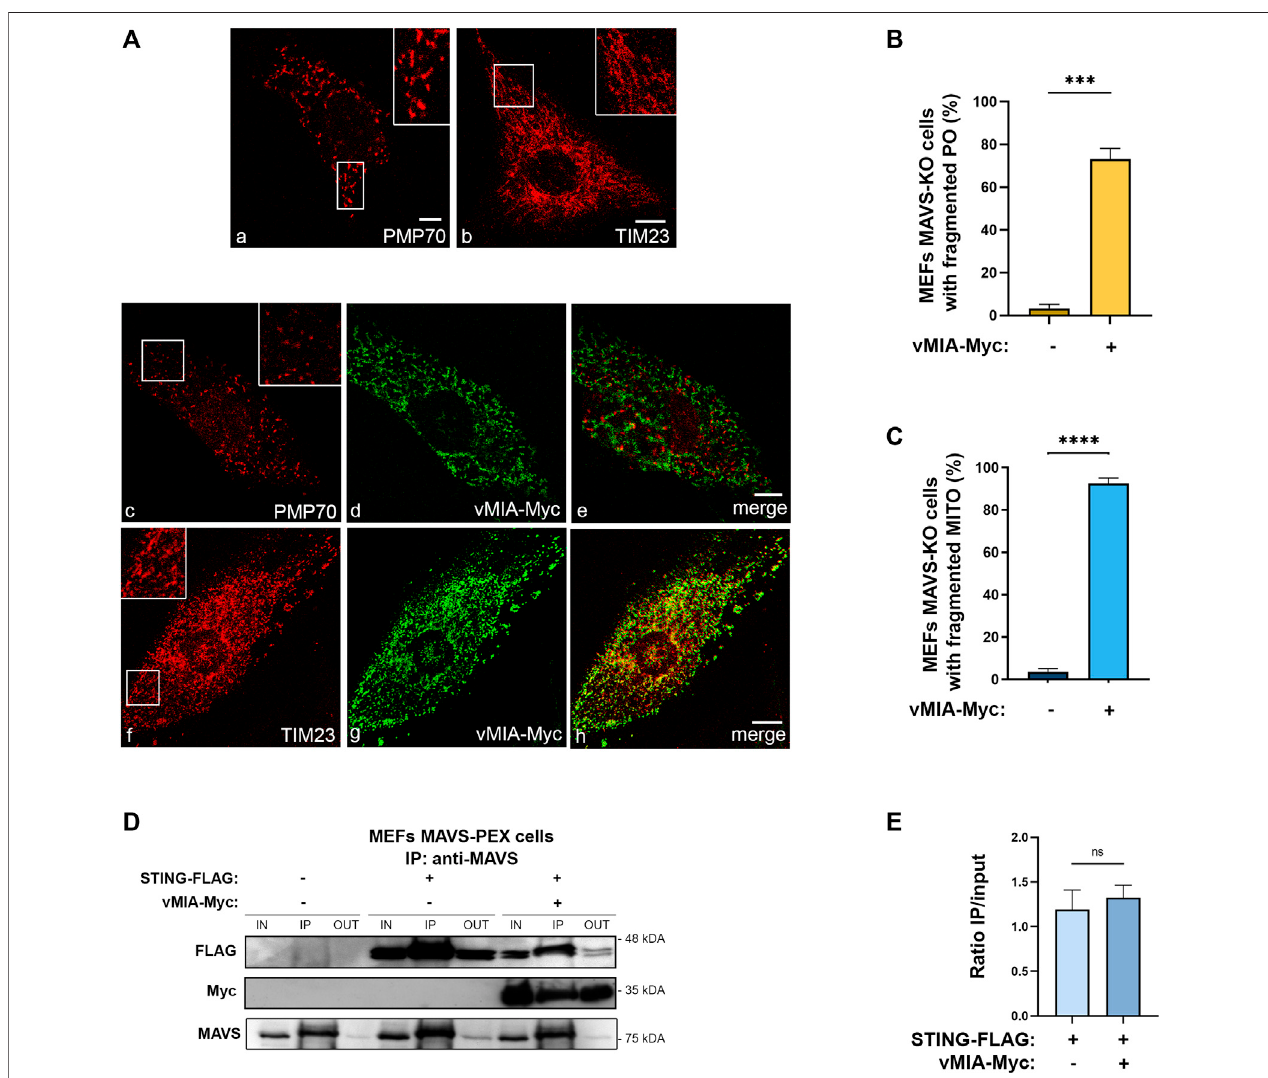
FIGURE3| vMIA-inducedperoxisomalandmitochondrialfragmentationisindependentofMAVS.vMIAdoesnotdisruptSTING-MAVSinteractionatperoxisomes. (A) Immuno fl uorescenceanalysesofMEFsMAVSKOcells:(a,b)peroxisomalandmitochondrialmorphologiesincontrolcells:(a)anti-PMP70,(b)anti-TIM23;(c – e)peroxisomal morphologyuponoverexpressionofvMIA-Myc:(c)anti-PMP70,(d)anti-Myc,(e)mergeimageofcandd;(f,h)mitochondrialmorphologyuponoverexpressionofvMIA-Myc: (f) anti-TIM23, (g) anti-Myc, (h) merge image of f and g. Bars represent 10 µm. (B,C) Statistical analysis of peroxisomal or mitochondrial morphologies upon overexpression of vMIA-Myc in MEFs MAVS KO cells, respectively. Approximately 600 cells were analysed per condition. (D) Co-immunoprecipitation analysis of the interactionbetweenoverexpressedSTING-FLAGandvMIA-MycinMEFsMAVS-PEXcells.Thepull-downwasperformedusinganantibodyagainstMAVS.Westernblotwas performedwithantibodiesagainstFLAGand Myc.INrepresentstotalcelllysate(input),IPrepresentsimmunoprecipitationandOUTrepresentsthecelllysateextractedafter incubation with the antibody (output). (E) Quanti fi cation of the ratio between IP and IN, in the presence or absence of vMIA. Data represents the means ± SEM of three independent experiments, analysed using unpaired T test (ns - non-signi fi cant; *** – p < 0.001, **** – p < 0.0001).